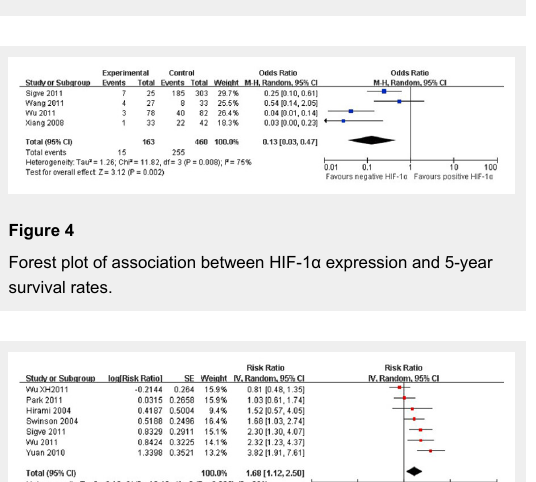
Figure 3 Forest plot of COX-2 positive expression in positive and negative HIF-1α tumour tissues.